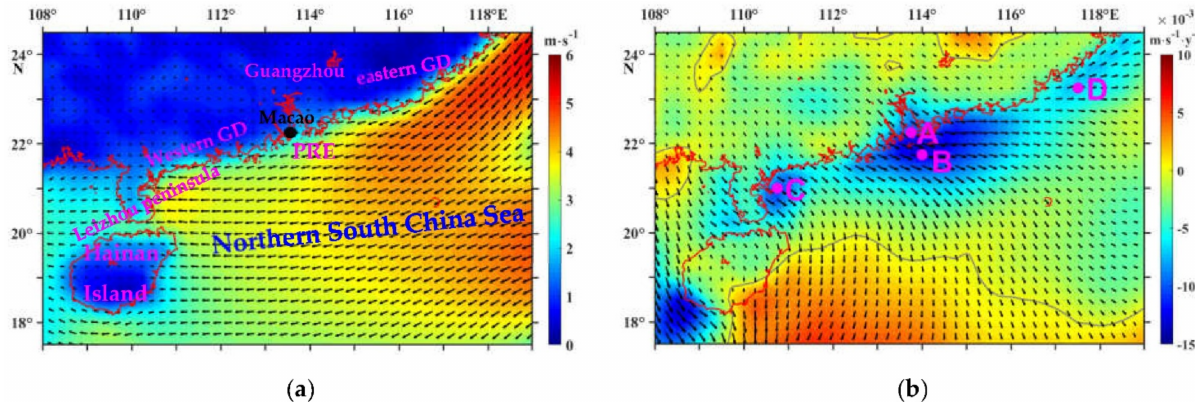
Figure 1. Bathymetry of the South China Sea (SCS). The northern SCS is denoted by the red rectangle.